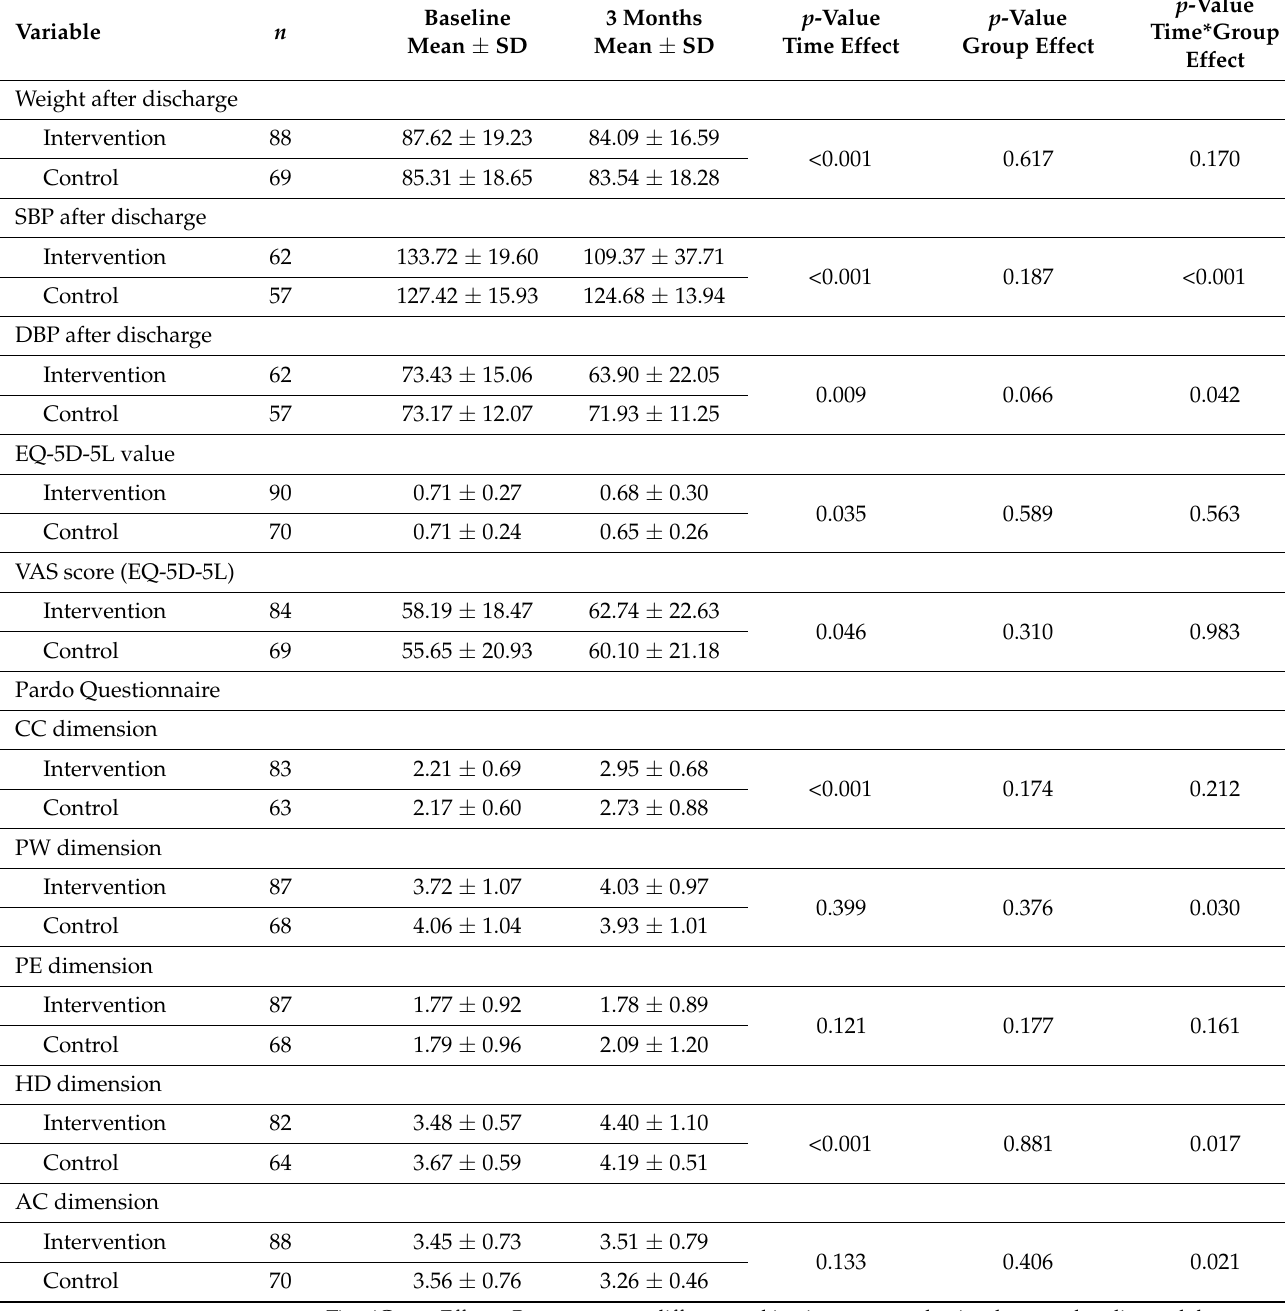
Table 3. Comparison of outcome variables between baseline and three